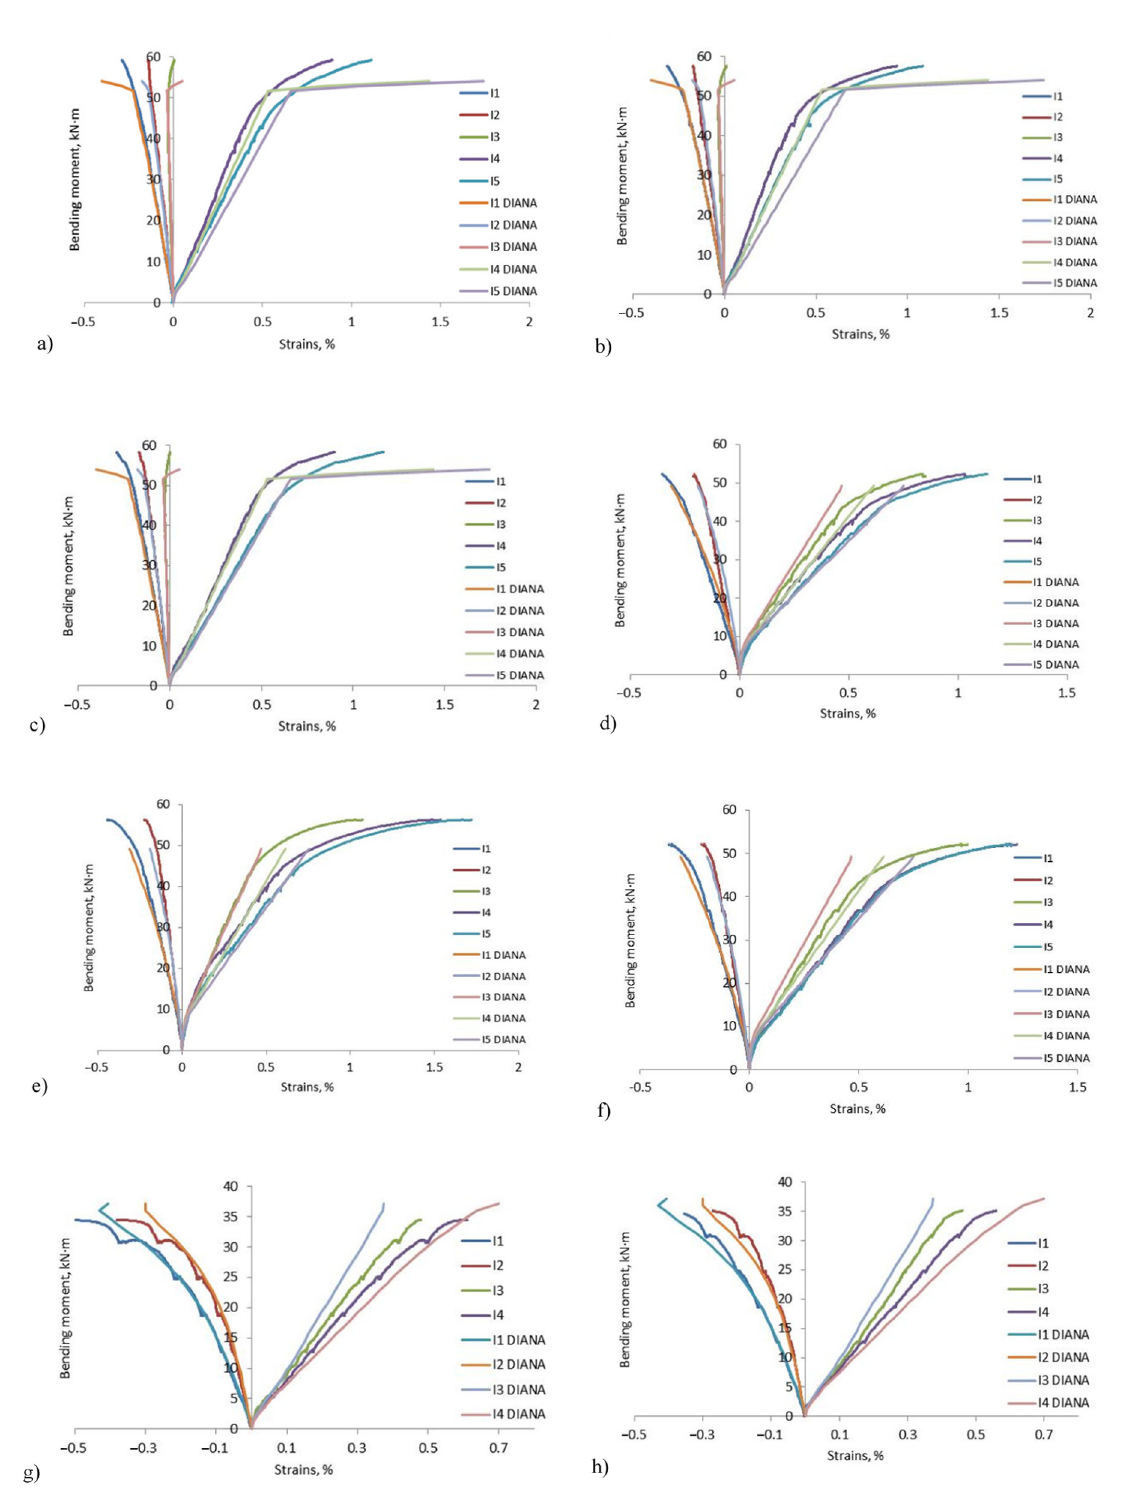
Fig. 9. Bending moment and strains curves: (a) S1T beam, (b) S2T beam, (c) S3T beam, (d) S4U beam, (e) S5U beam, (f) S6U beam, (g) S7 beam, (h) S8 beam, (i) S9